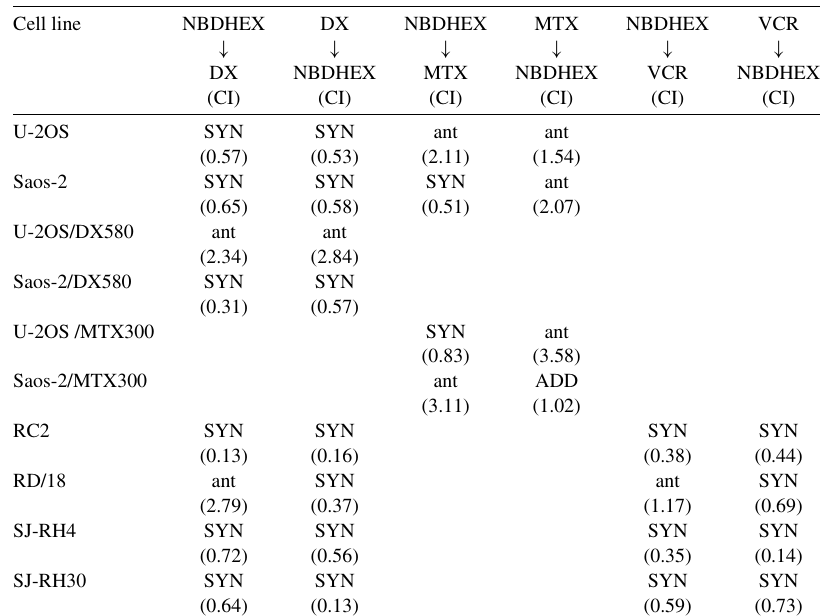
Effects of the in vitro sequential administration of NBDHEX and doxorubicin (DX), methotrexate (MTX), cisplatin (CDDP) or vincristine (VCR) in human osteosarcoma and rhabdomyosarcoma cell lines